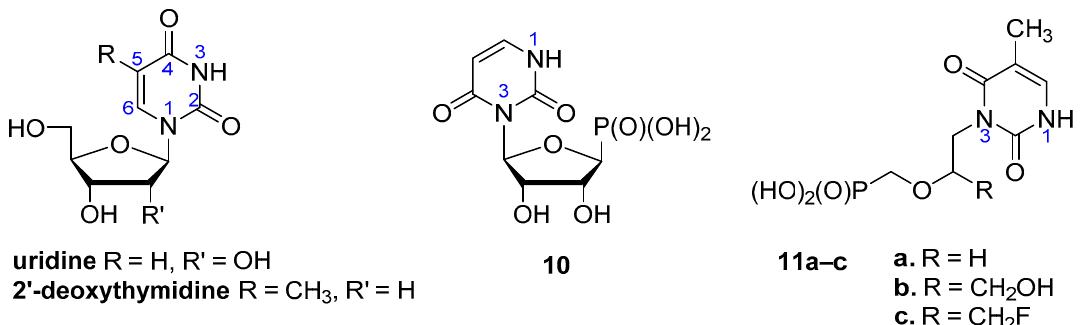
3 of 18 Figure 2. Examples of quinazoline-2,4-dione-containing nucleosides and nucleotides analogues.